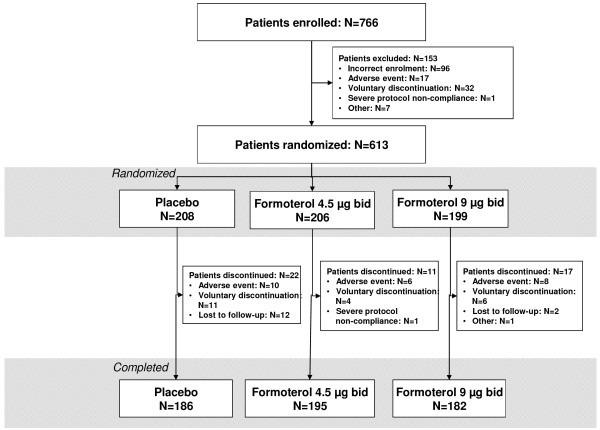
Patients flow through the study.